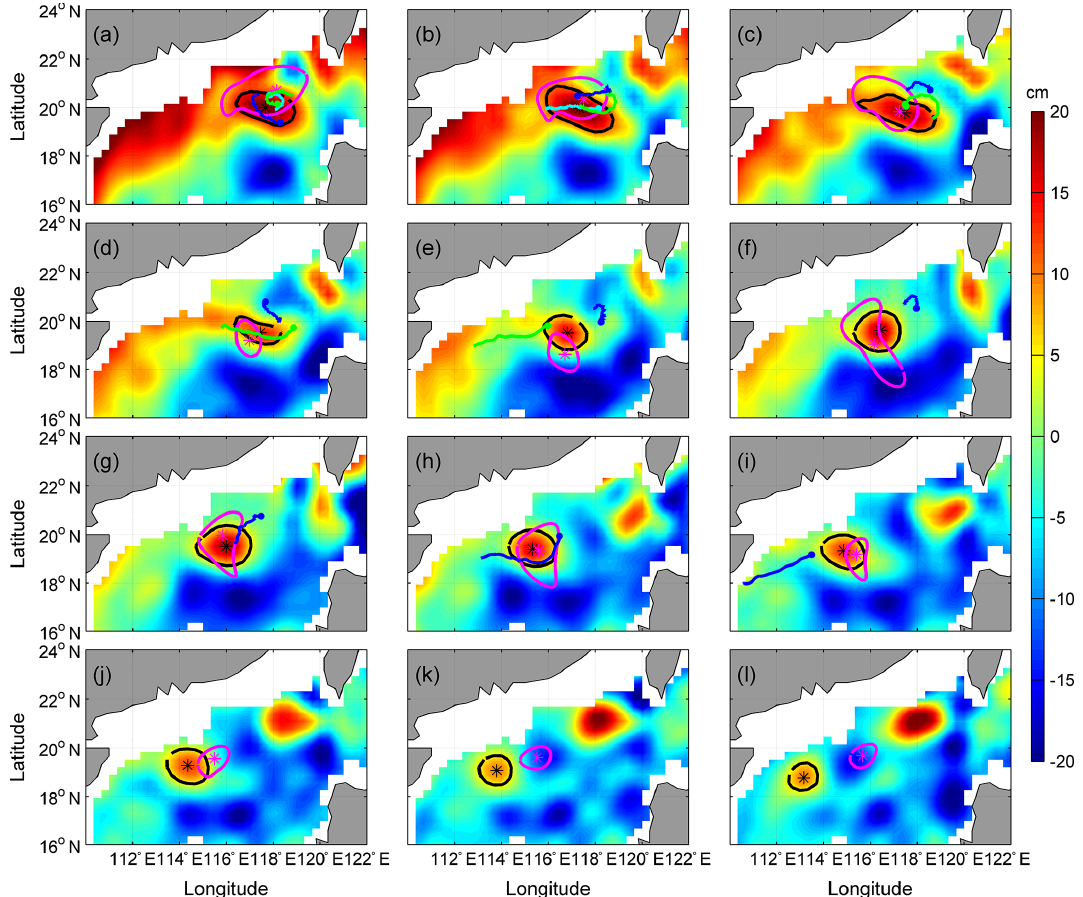
Figure 6. Comparisons of AE1 derived from weekly SLA of assimilation results and observation from satellite remote sensing during the period of December 2003–February 2004. Background color is SLA; “*” symbols mark and closed lines indicate the center position and the outermost closed isoline of AE1, respectively; the black line is from satellite observation SLA and the pink line is from assimilation SLA. The cyan, green, and blue solid circular lines indicate the start positions and trajectories of numbers 22517, 22918, and 22610 drifter buoys, respectively; (a–l) is SLA on the 3 December 2003–18 February 2004, respectively; unit: